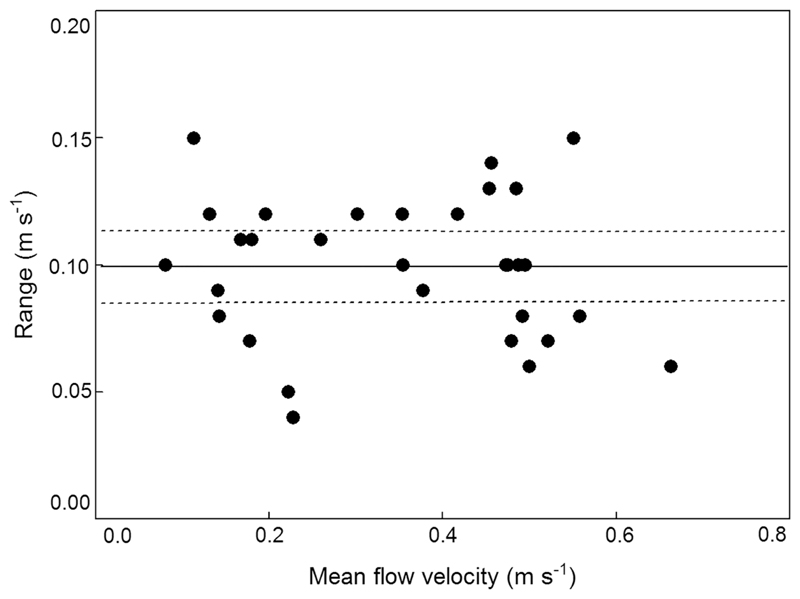
Relationship between mean flow velocity (m s−1) and range of 31 spatio-temporally filtered flow velocity series of 30 to 301 s duration (intervals = 1 s); showing mean (black line) with 95% CL (dotted lines)